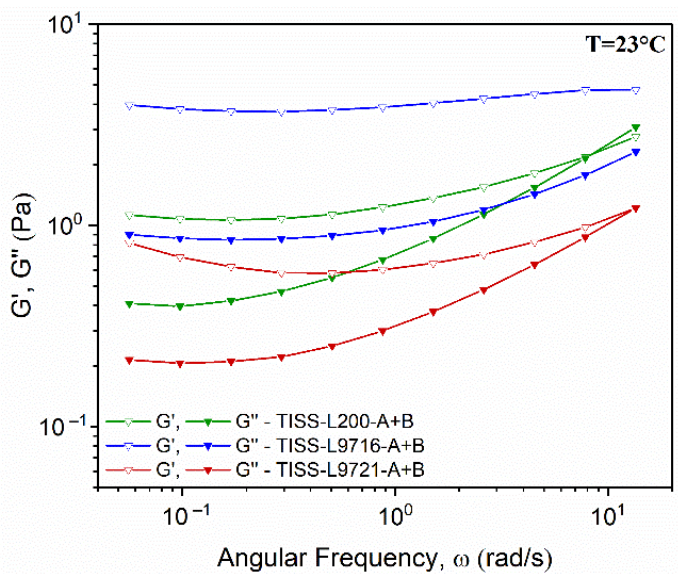
Figure 6. Oscillatory tests—frequency dependence of dynamic moduli for TISS liquid paints, prepared with various binders (L200, L9716 in L9721) and black pigment (Black-444). All liquid paints were measured after the addition of catalyst Desmodur N75.